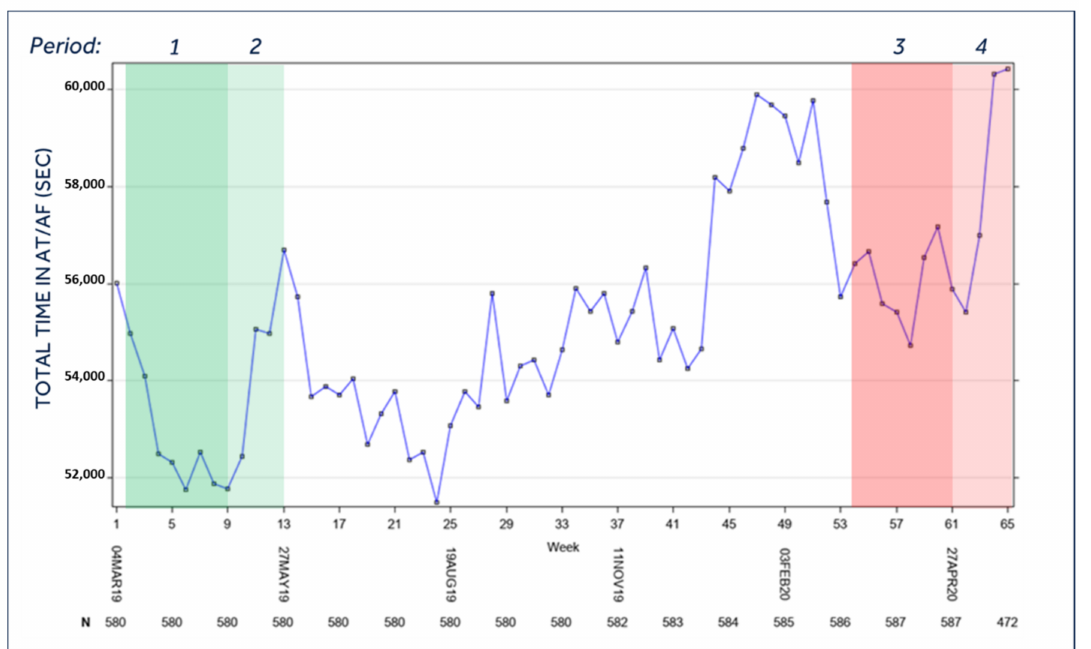
Figure 2. Total time in AT/AF of the entire population during the study period. Legend: Period 1 = Lockdown con- trol period (year 2019); Period 2 = Post-lockdown control period (year 2019); Period 3 = Lockdown period (year 2020); Period 4 = Post-lockdown period (year 2020). For the temporal definition of the three periods please see the Methods section; AT/AF = atrial tachycardia/atrial fibrillation; p = 0.0150 for mean period 3 vs. mean period 1 ; p = N.S. for all other